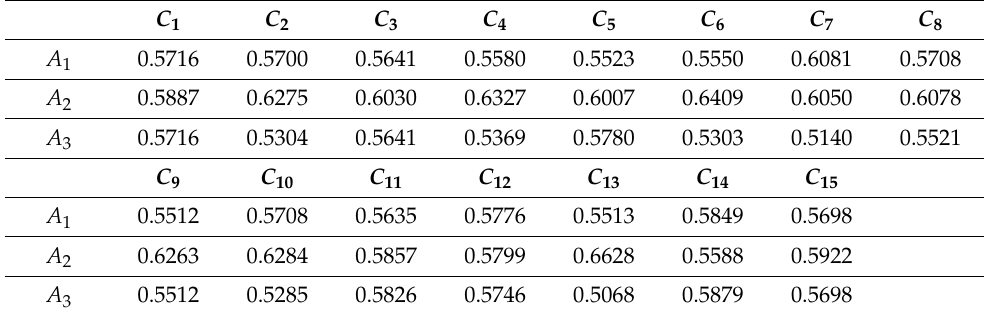
Table 5. Normalized evaluation matrix table.